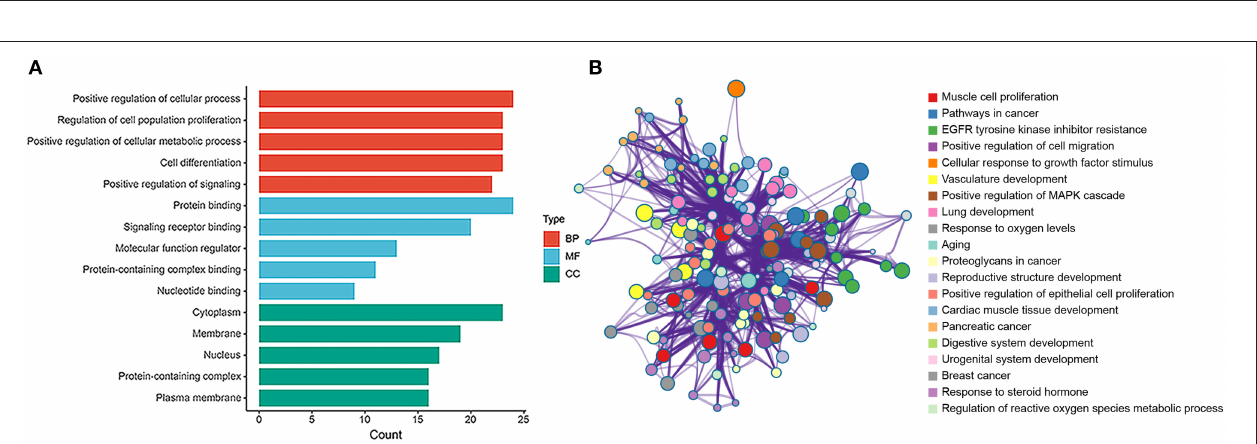
FIGURE 6 | The potential interactions of hub genes in the PPI network in aortic vascular tissues of rats. (A) The top 30 hub genes were selected by the cytoHubba app in Cytoscape 3.8.2 software; The node color changes gradually from yellow to red in ascending order according to the score of hub genes. (B) The protein and protein interaction of top 30 hub genes by the online database STRING (involving 30 nodes and 344 edges). PPI, protein and protein interaction.